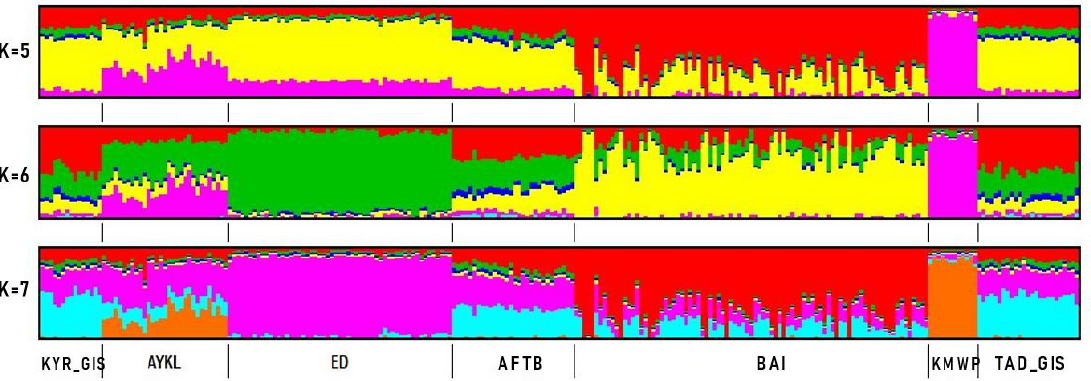
Figure 4. Assessment of population genetic structure in different sheep breeds. Afghan fat-tailed breed (AFTB), Aykol (AYKL), Edilbay (ED), KYR_GIS (Gissar breed—imported from Kyrgyzstan), Baisary (BAI), Kazakh meat-wool breed (KMWB), TAD_GIS (Gissar breed — imported from Tajikistan).